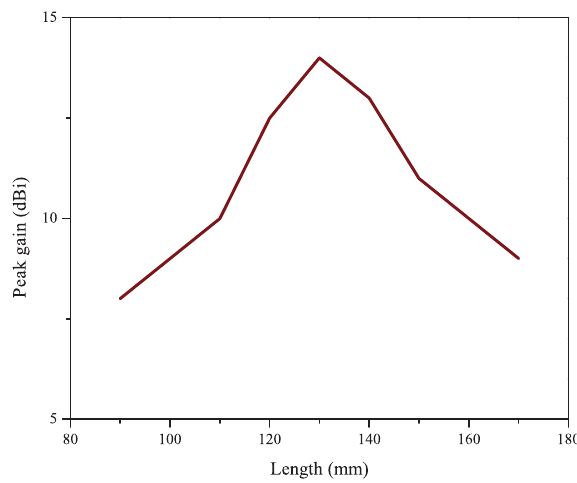
Figure 6. Formulated variation of peak gain with length of SSPP.